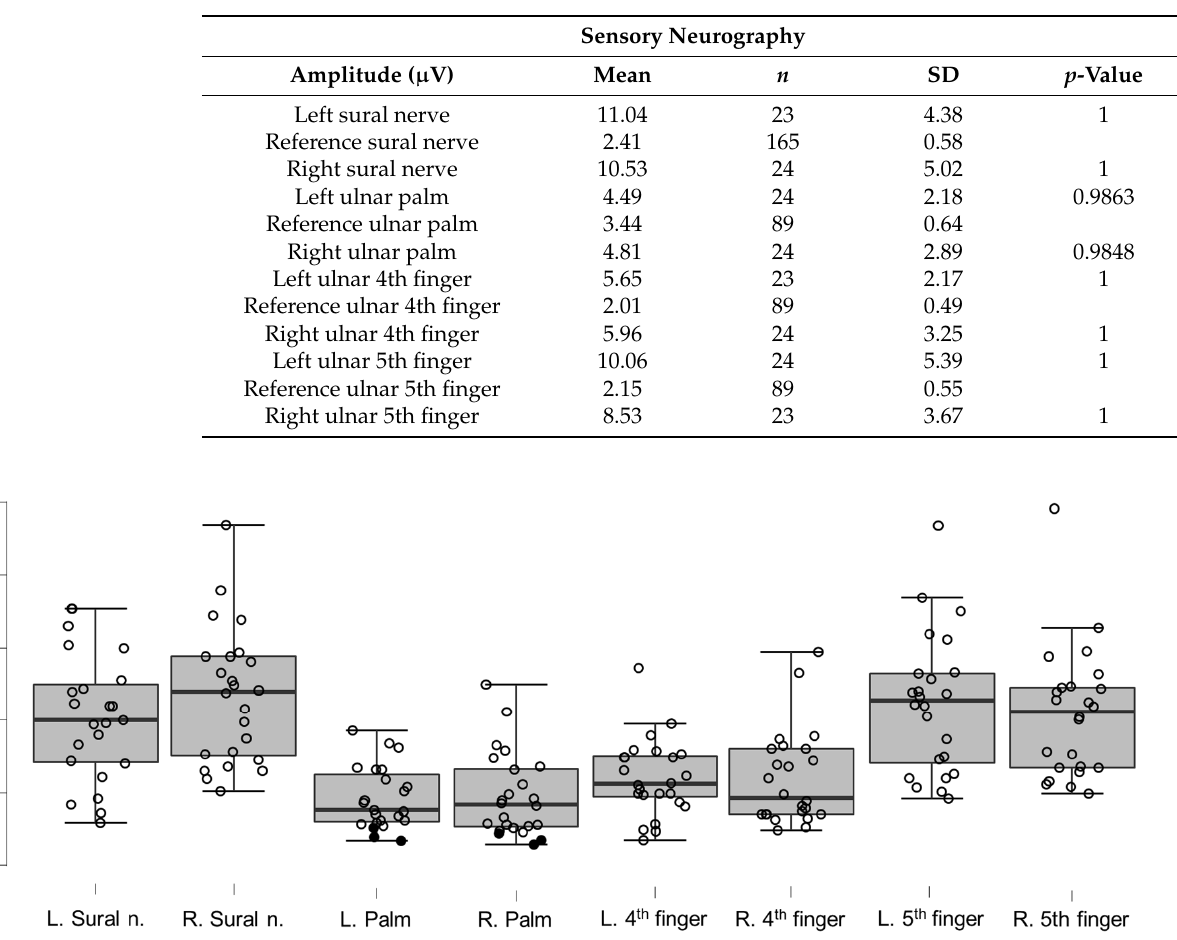
Table 8. Sensory neurography amplitudes for left and right sural and ulnar nerves.